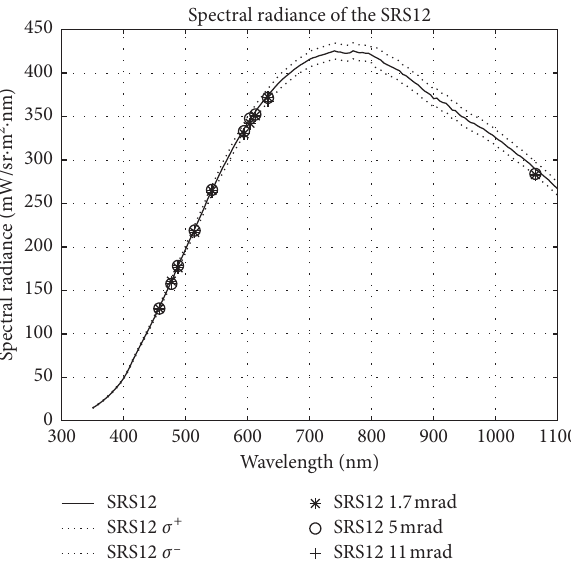
Figure 4: Spectral radiance of the SRS12 reference radiation source for all mrad FOV